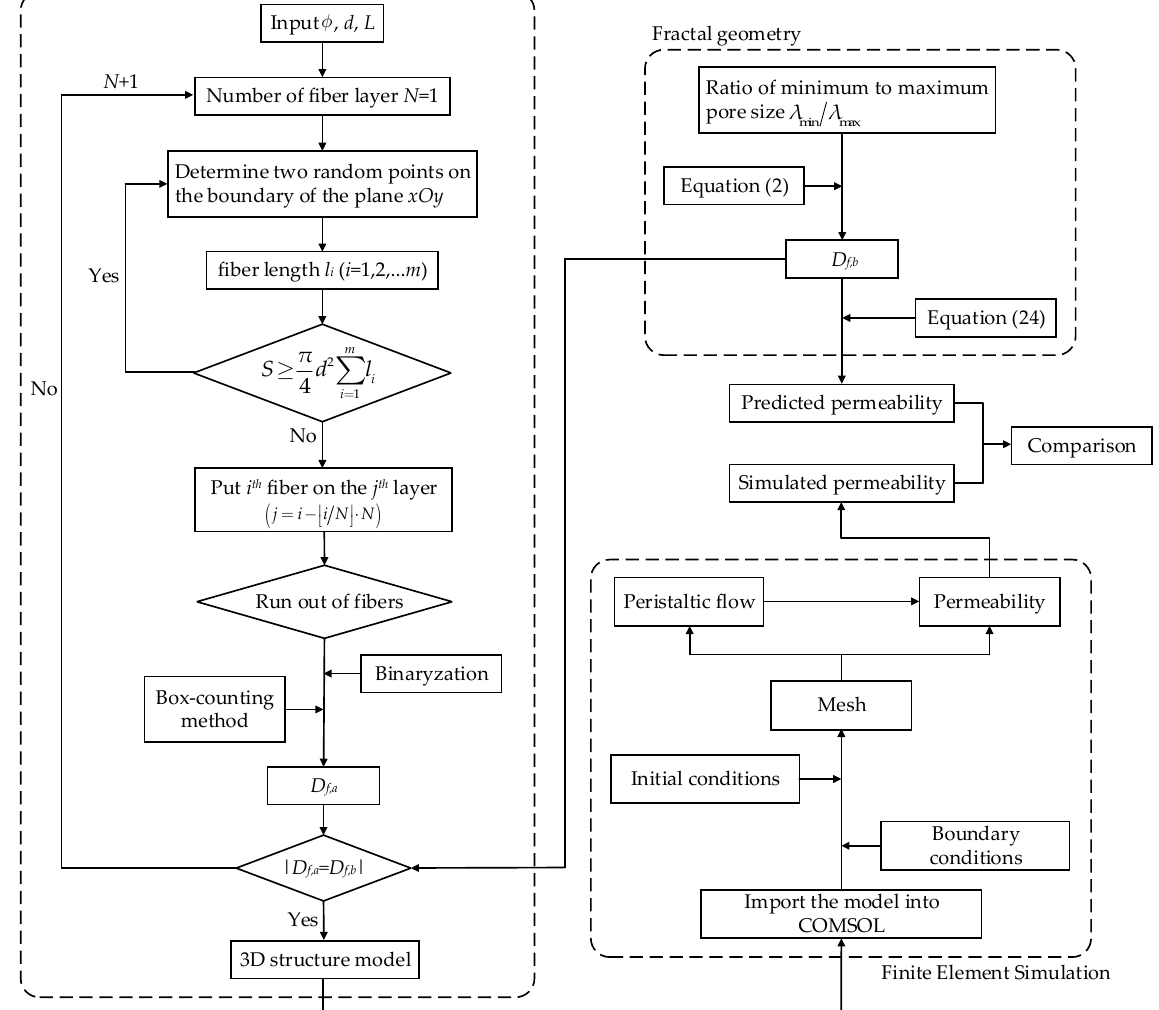
Figure 3. Flowchart of fractal reconstruction and FEM simulation.